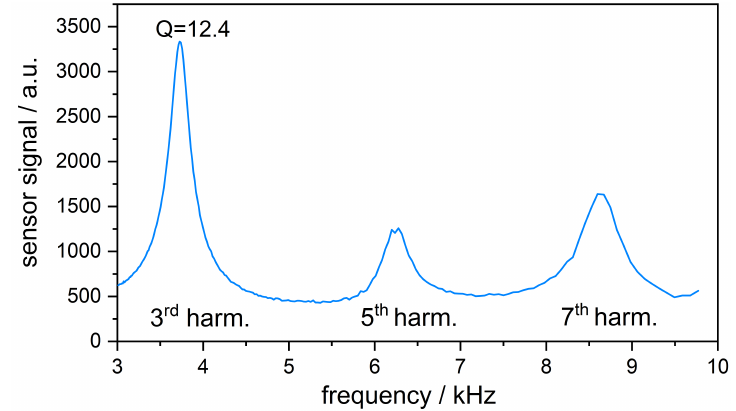
Figure 5. Frequency response of the resonant photoacoustic cell with peaks of different harmonics: 3rd at 3727 Hz, 5th at 6275 Hz, 7th at 8635 Hz. The 3rd harmonic gives the best signal and has a Q-factor of around 12.4.